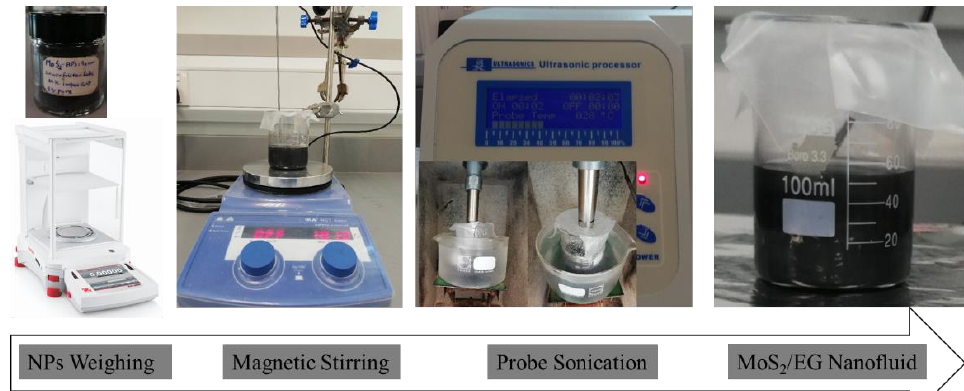
Figure 1. Preparation steps of MoS 2 /EG nanofluids.